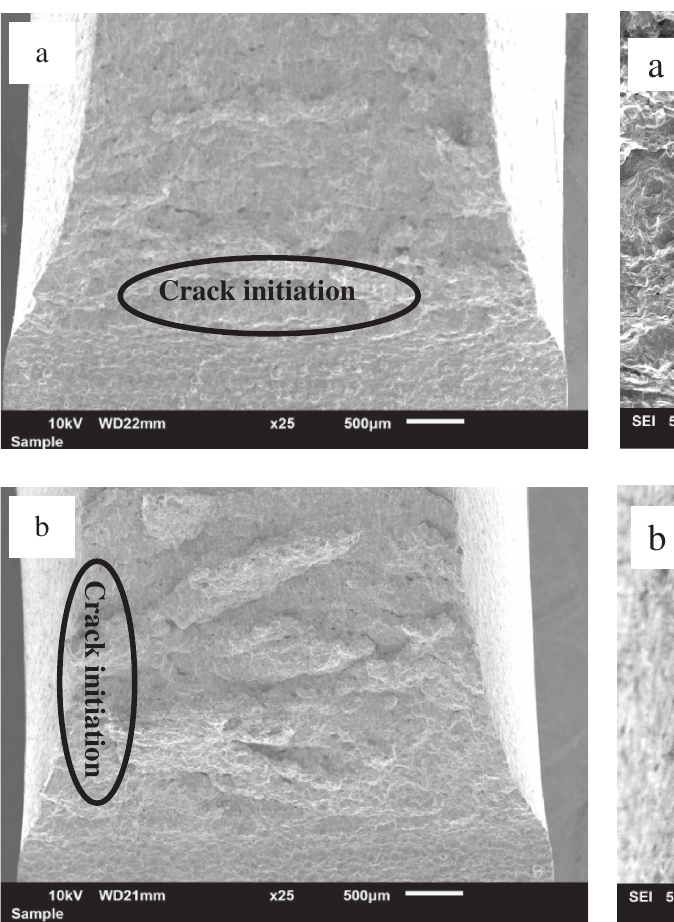
Figure 8: SEM images of impact sample fracture. (a) Fracture of impact sample before LSP; (b) Fracture of impact sample after LSP.